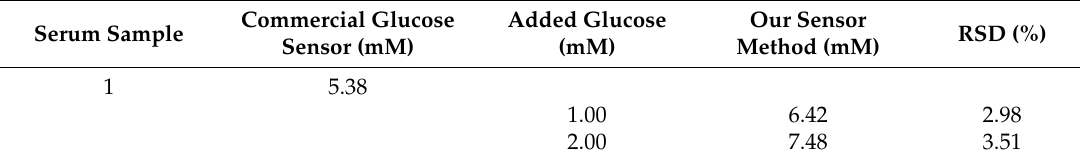
Table 4. Glucose detection in serum by a commercial glucose sensor and our sensor method ( N = 3). Serum